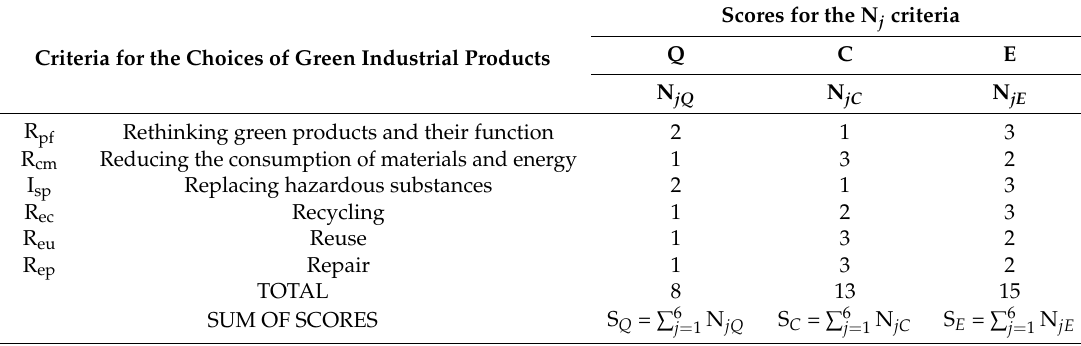
Table 3. Criteria and scores for the choices of green industrial product “Tractor Truck 18.5 tons”.